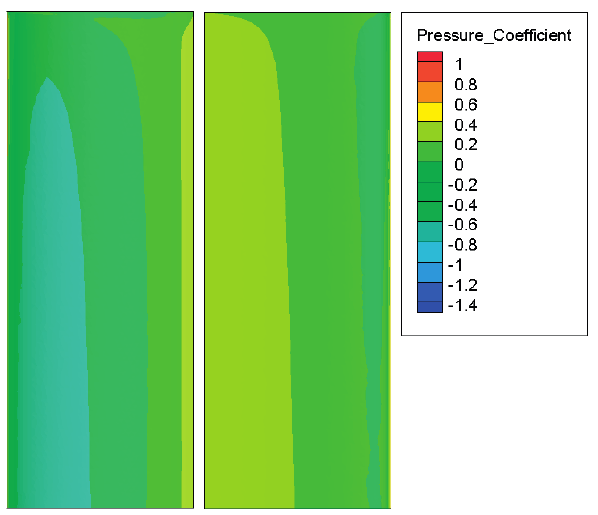
Figure 28. Contour of pressure coefficient corresponding to high speed flow configuration.